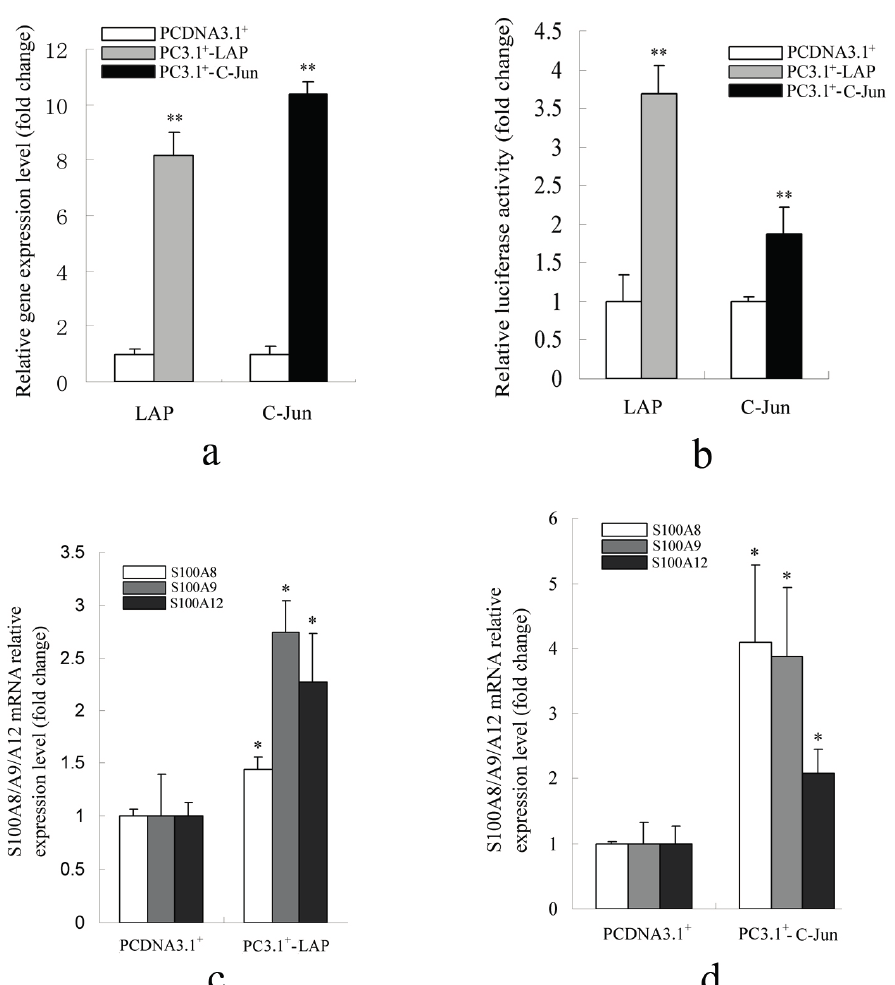
Figure 2. Promoter activity and expression pattern of S100A12 gene when LAP or C-Jun were overexpressed. ( a ) The detection of the expression level of C/EBP β and C-Jun when their overexpression constructions were transfected in PK-15 cells; ( b ) The promoter activity of S100A12 was increased when LAP or C-Jun were overexpressed; ( c ) The mRNA levels of S100A8/A9/A12 were increased when LAP was overexpressed; ( d ) The mRNA levels of S100A8/A9/A12 were increased when C-Jun was overexpressed. PCDNA3.1 + was used as negative control. The value of the PCDNA3.1 + (control group) was set as 1. Error bars represent mean ± SEM, representative of at least three experiments. LAP, C-Jun vs. PCDNA3.1 + ; * indicates a significant difference ( p < 0.05); ** indicates a significant difference ( p <